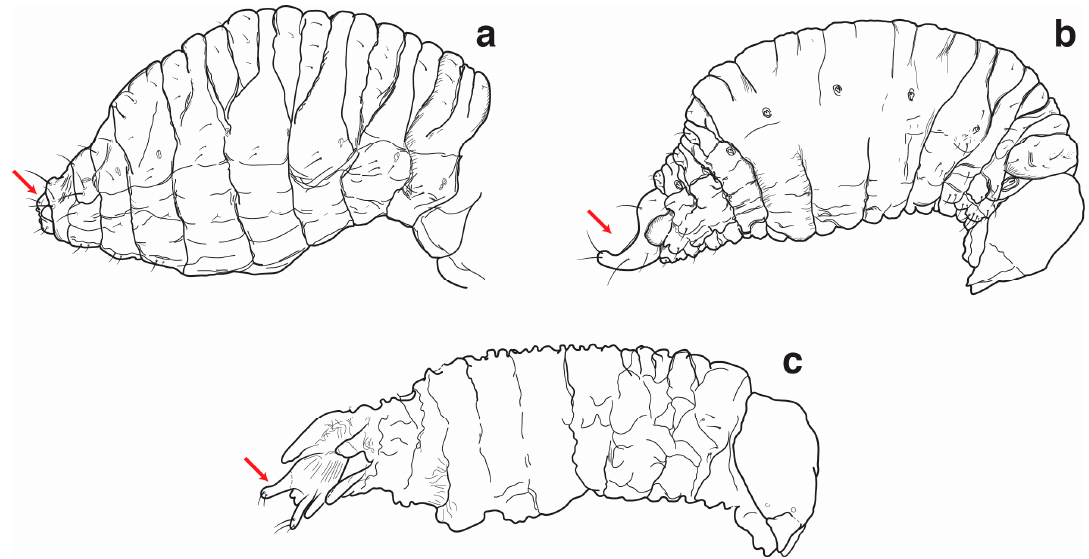
Figure 13. Larvae, lateral view: ( a ) Eugnoristus (abdomen only); ( b ) Phacecorynes ; and ( c ) Nephius (= Anius ).